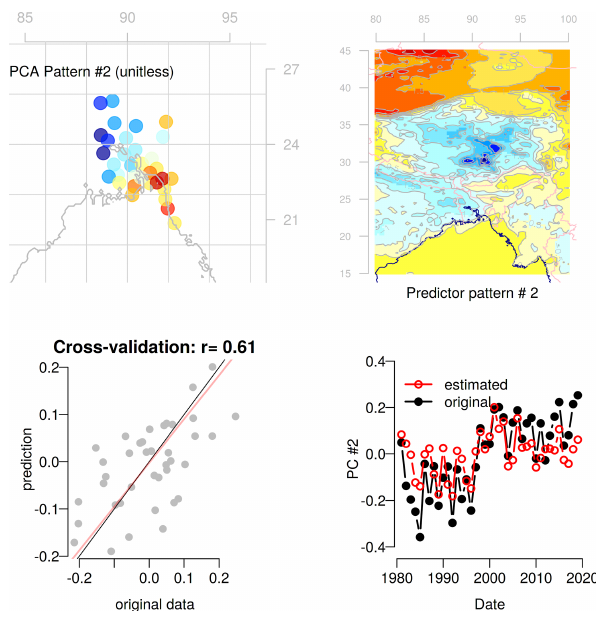
Figure 5. Evaluation of the statistical downscaling of the maximum temperature in the pre-monsoon season (March–May) for the sec- ond leading principal component of the predictand (PC2). Details like in Fig.